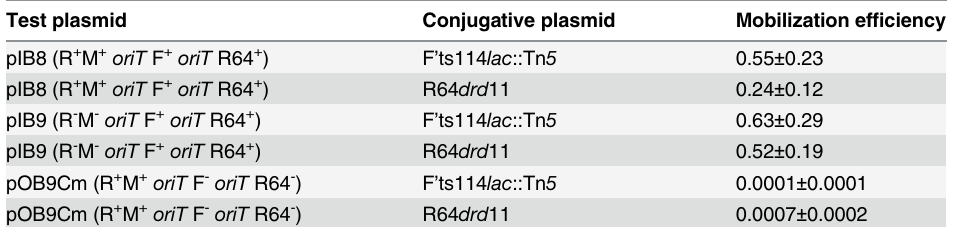
Test plasmid Conjugative